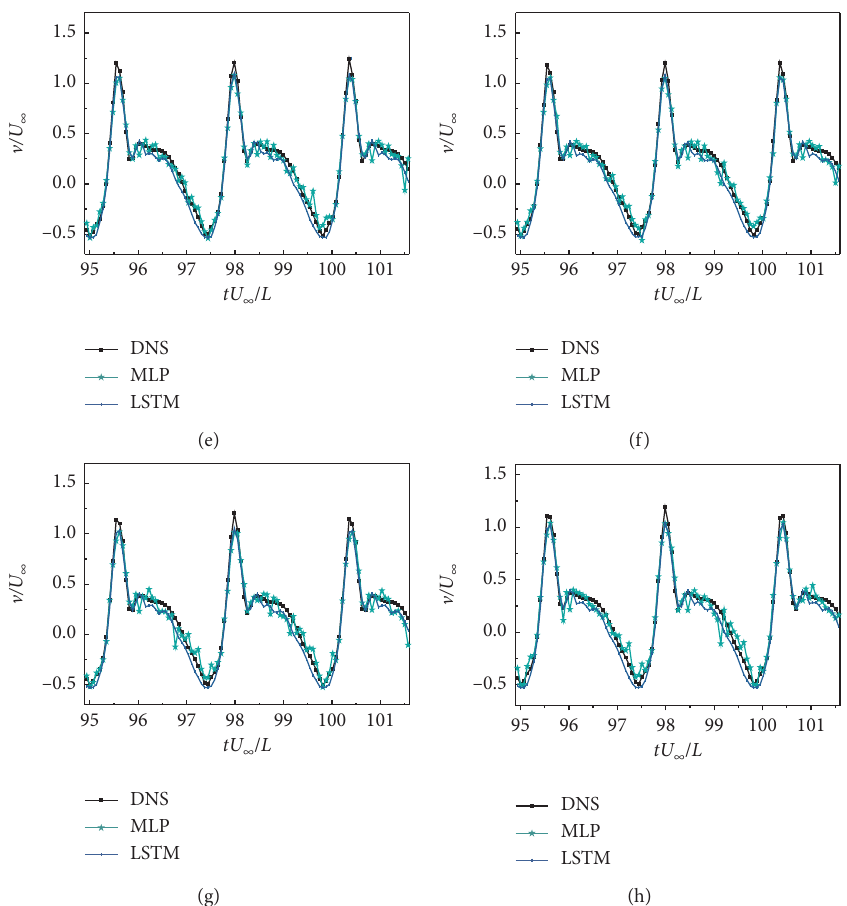
Figure 12: Comparison of the time trace of velocity. (a) Ma � 0.53, (b) Ma � 0.54, (c) Ma � 0.55, (d) Ma � 0.56, (e) Ma � 0.57, (f) Ma � 0.58, (g) Ma � 0.59, and (h) Ma �